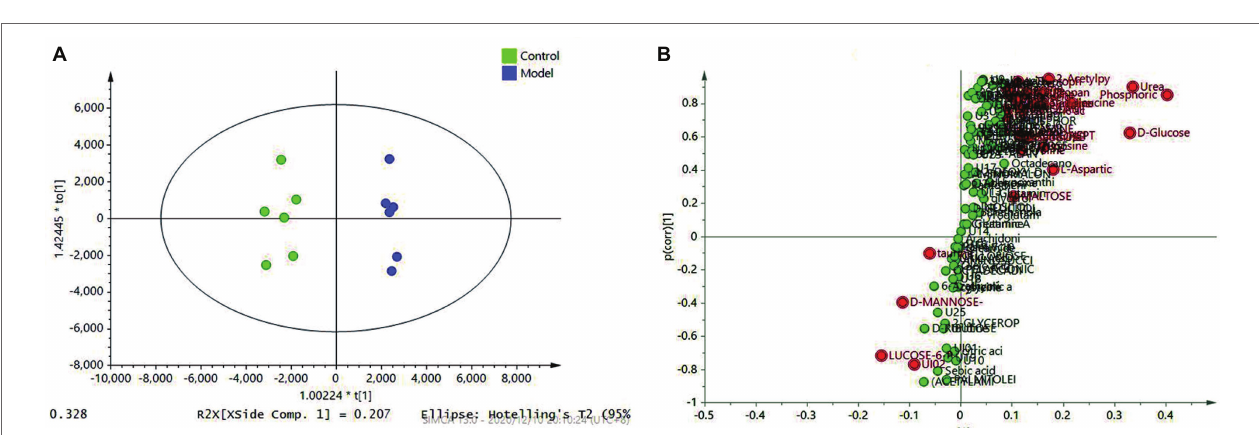
FIGURE 5 | PLS-DA analysis revealed the different metabolic patterns and the discriminant metabolites induced by the HAMI model and normal control based on metabolites in the myocardial tissue. (A) PLS-DA between the model and the control; (B) S-plot analysis of metabolites differentiating the model and the